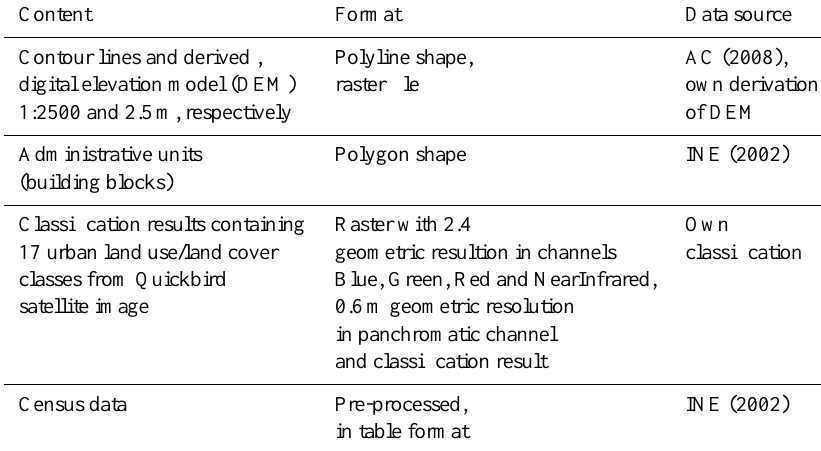
Table 1. Overview about available